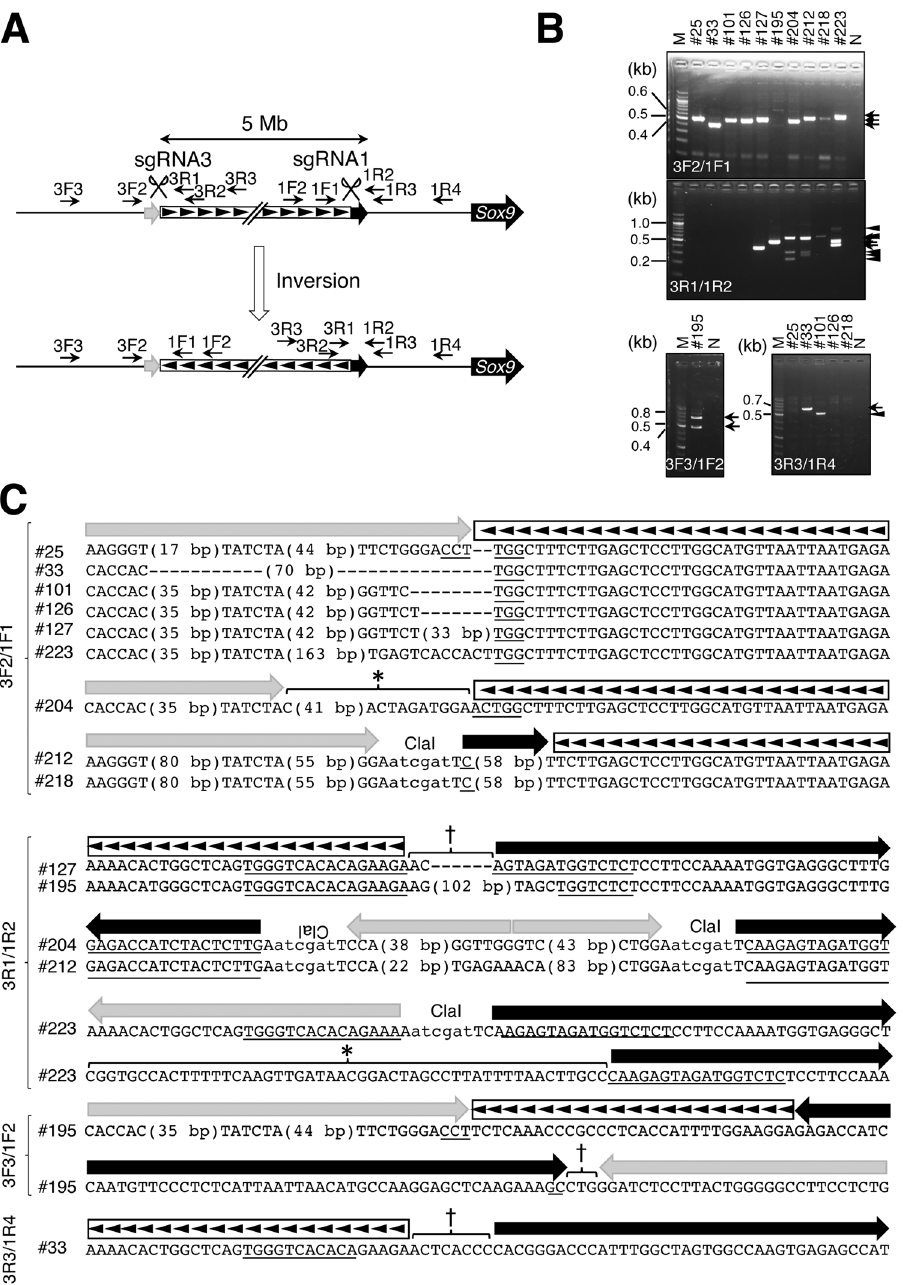
Figure 4. Generation of mutant mice with a 5-Mb inversion. ( A ) Schematic representation of the 5-Mb region upstream of Sox9 . The black line represents a genome sequence. Homology arms are indicated with black (arm1) and gray (arm3) boxes. PCR primers are indicated with arrows. The inverted region is denoted by a box containing arrowheads. ( B ) Agarose gel electrophoretogram images of PCR products amplified using 3F2/1F1 (upper panel), 3R1/1R2 (middle panel), 3F3/1F2 (lower left panel), and 3R3/1R4 (lower right panel) primer sets and DNA prepared from the embryos. Sample ID is indicated at top of each panel. Arrows and arrowheads indicate positive and nonspecific signals, respectively. M: a 100-bp DNA ladder (markers); N: no- template control. ( C ) Sequences of inversion junctions. Results of direct sequencing of PCR products shown in ( B ). Corresponding sequences of arms and inverted sequences are shown at the top of each panel. Parts of gRNA recognition sequences are underlined. Asterisks indicate an unknown sequence. The obelisk indicates a genomic sequence nonhomologous to the arms or to an internal sequence flanked by sgRNA3 and sgRNA1. Black and gray arrows correspond to those in ( A ). The inverted region is indicated with a box containing arrowheads as shown in ( A